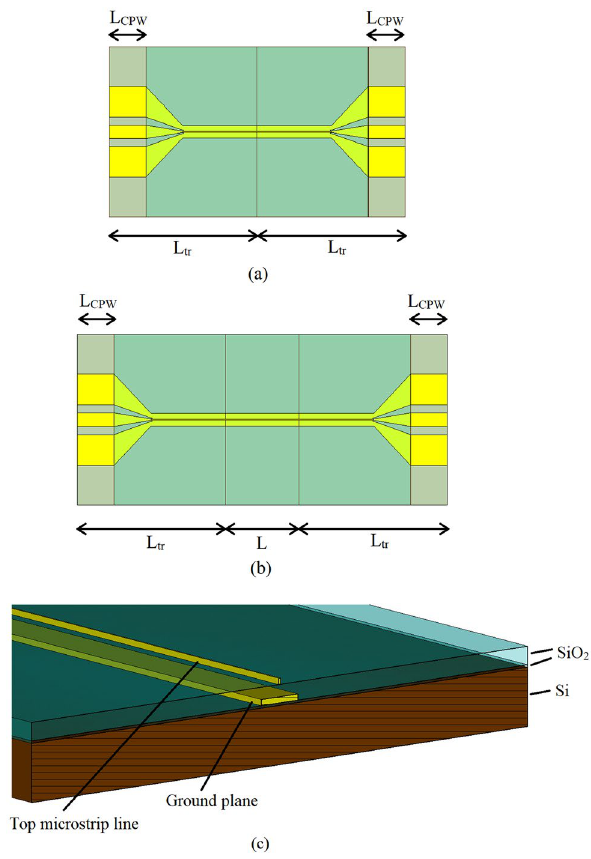
Figure 8. The two passive structures used in de-embedding; ( a ) Through standard, ( b ) Line standard, and ( c ) cross-section of passive devices.